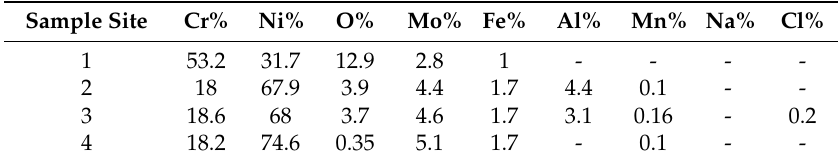
Table 9. The weight percentage of Inconel 625 sample cross section after 100 h heating.